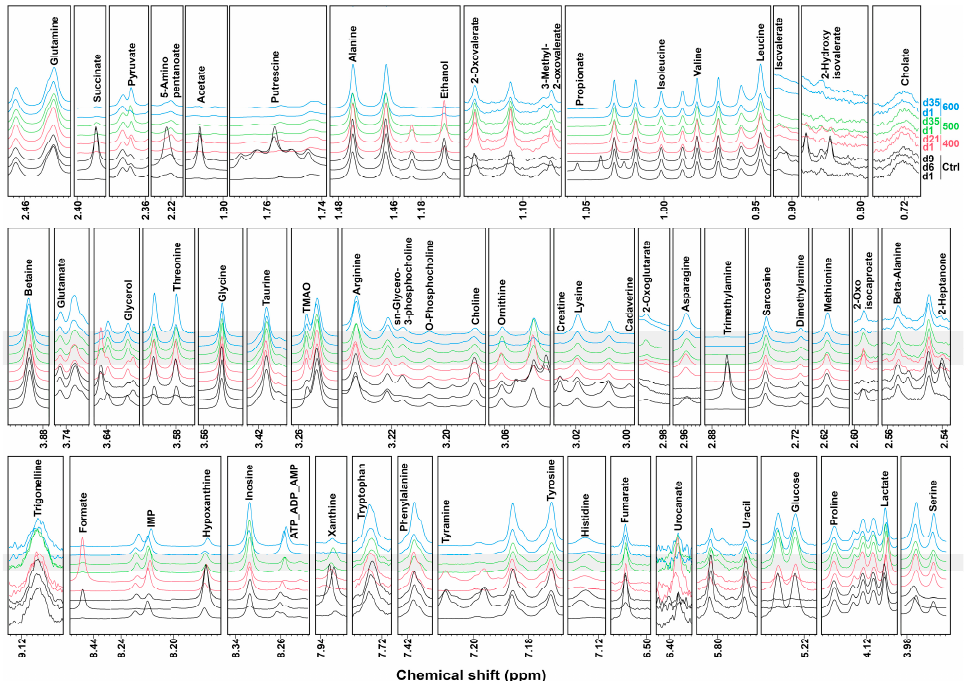
Figure 1. Examples of 1 H-NMR spectra registered on striped prawn samples analyzed for the inves- tigation.